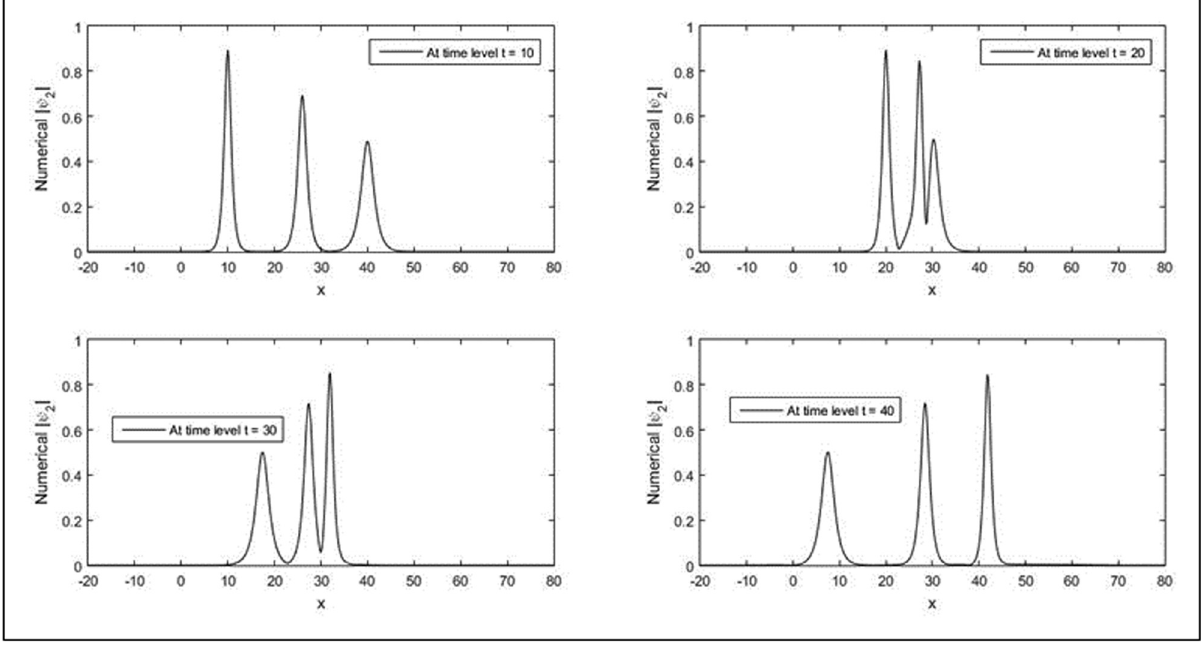
Figure 10: Interaction of three solitons for second - wave amplitude